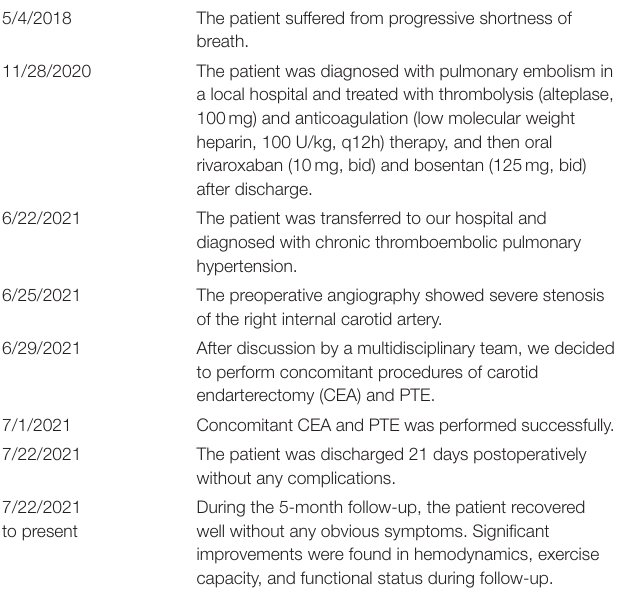
TABLE 2 | Detail timeline of clinical course of the patient. The patient suffered from progressive shortness of